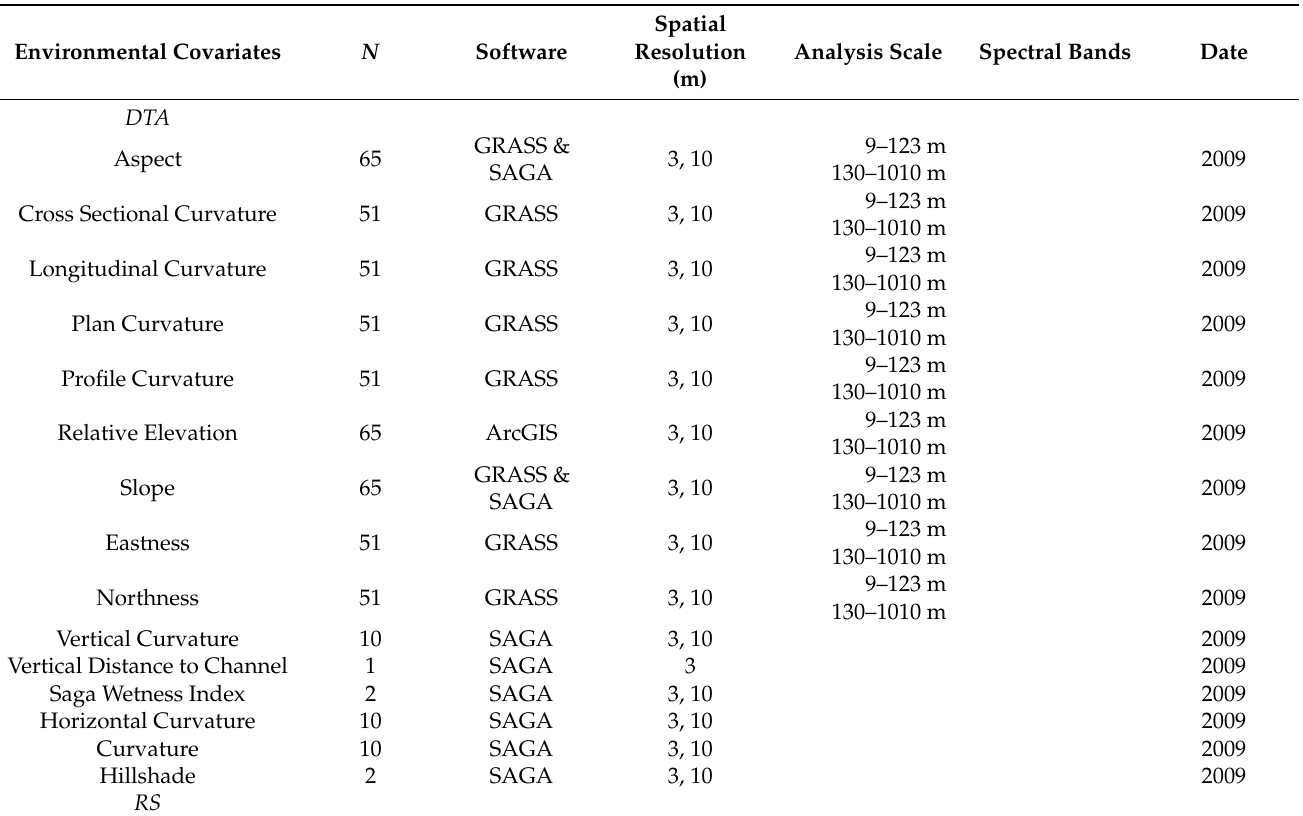
Table 2. Environmental variables included in the covariate stacks used in this study. DTA was performed on a LiDAR-based DEM. Imagery products were from the United States Department of Agriculture, Farm Service Agency’s (USDA-FSA) National Agriculture Imagery Program (NAIP) and the European Space Agency’s (ESA) Sentinel-2 satellites. NAIP was collected annually during the growing season by airplane. NAIP imagery from 2019 had a spatial resolution of 0.59 m, but was resampled to 3 m to match the resolution of other covariates. Sentinel-2 images were level-2A product, which provides orthorectified Bottom-Of-Atmosphere (BOA) reflectance with sub-pixel multispectral